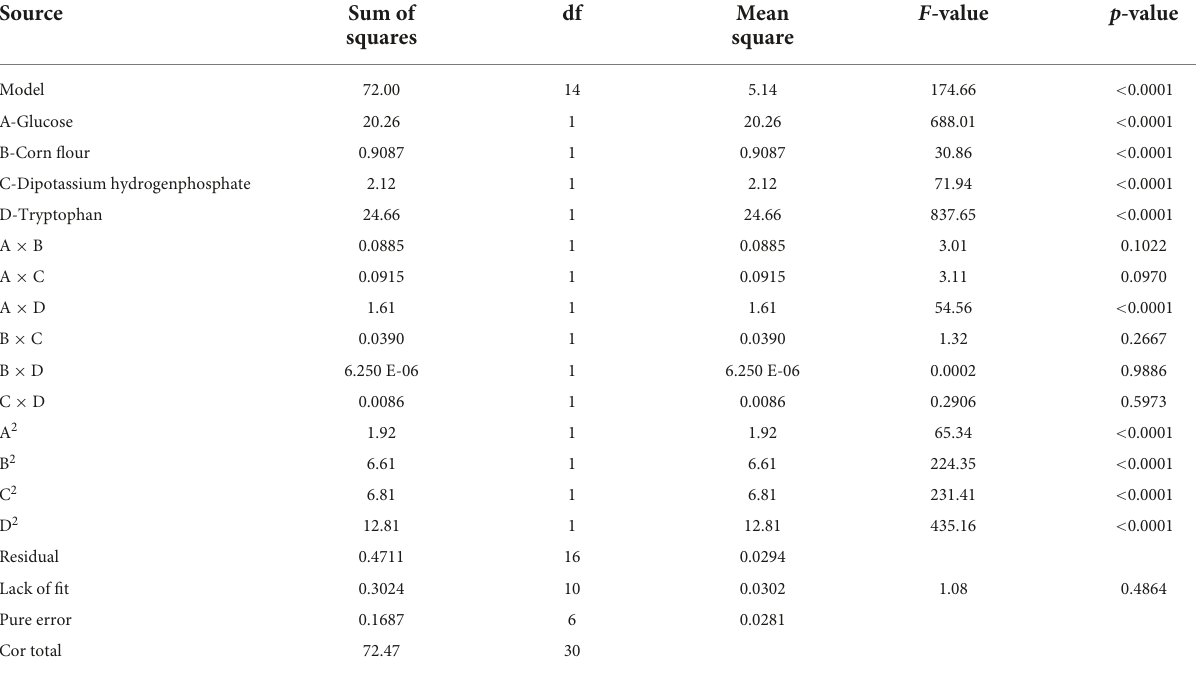
TABLE 6 Regression results of the CCD and ANOVA for quadratic model. Source Sum of